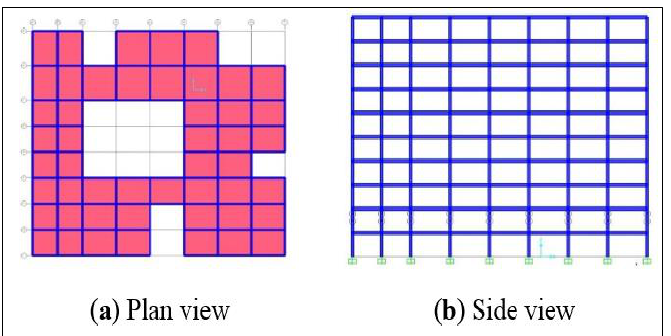
Figure 2: Plan and side view of isolated building.